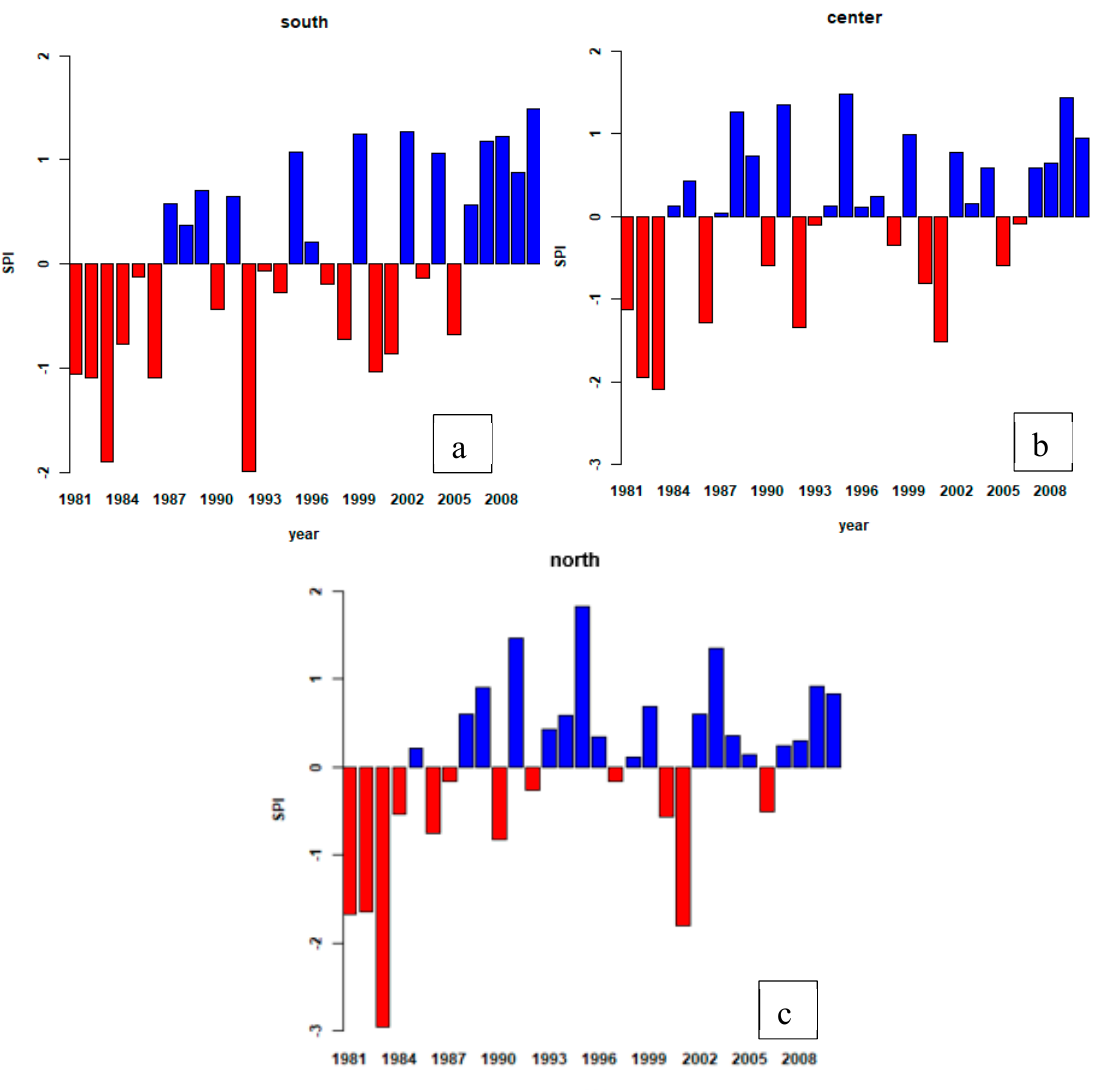
Figure 4. Standardized precipitation index of observed annual rainfall in the south ( a ), center ( b ) and north ( c ).